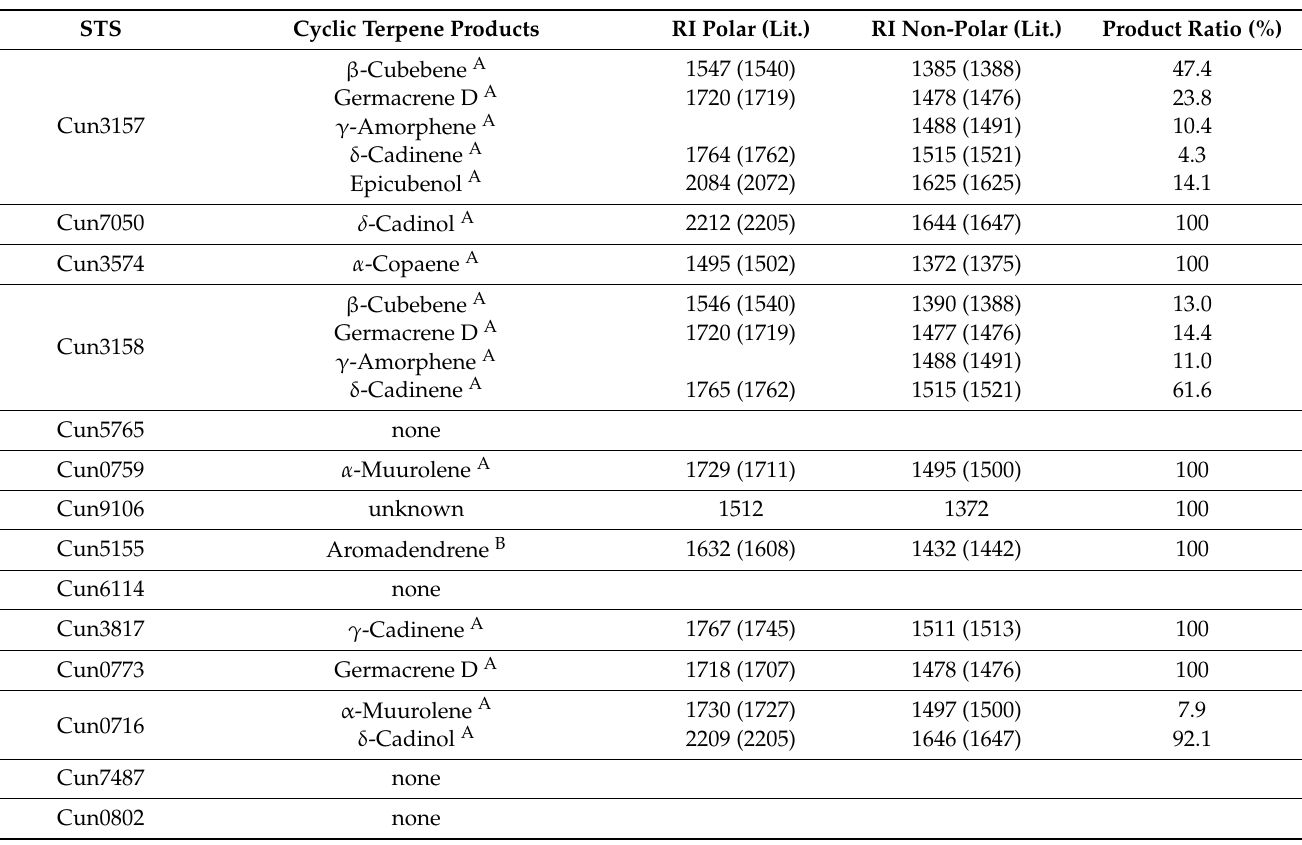
Table 2. Identified products of heterologous STS from C. unicolor . Product ratios are given to highlight the main products. STS Cyclic Terpene